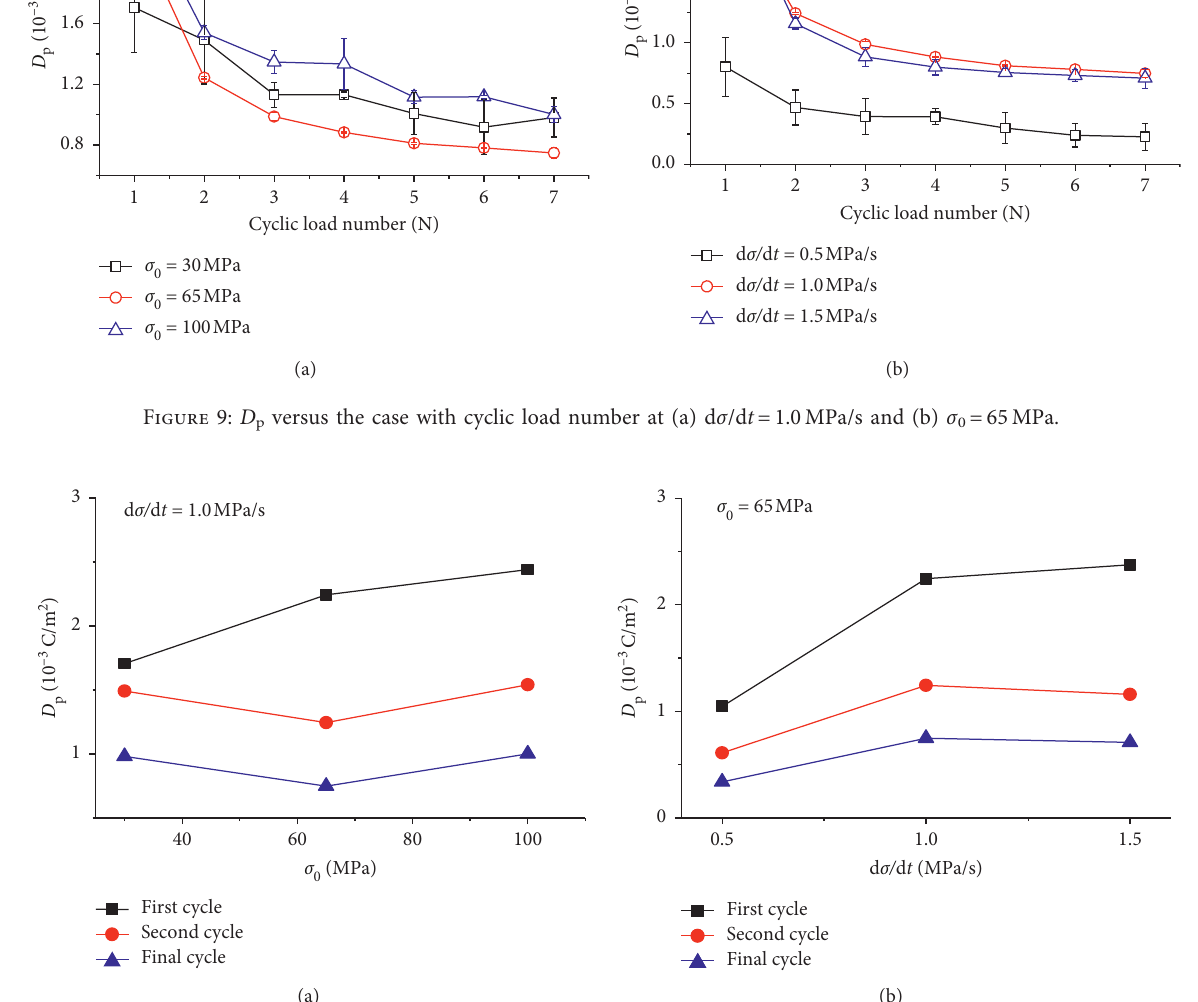
Figure 10: D p versus the case with (a) σ 0 and (b) d σ /d t during the 1st, 2nd, and final cycles.